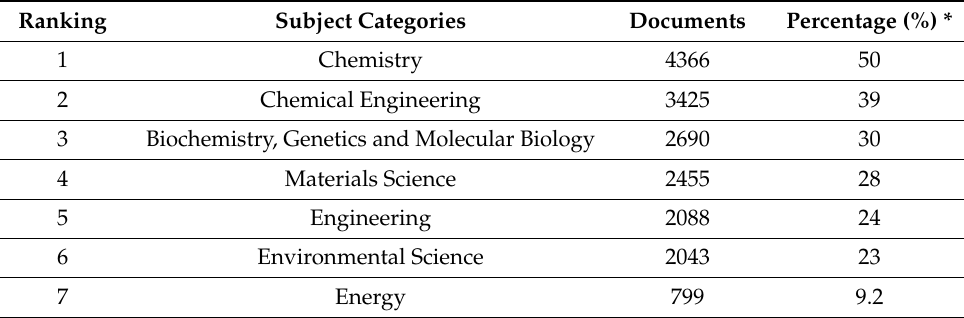
Table 3. The top most popular subject categories.